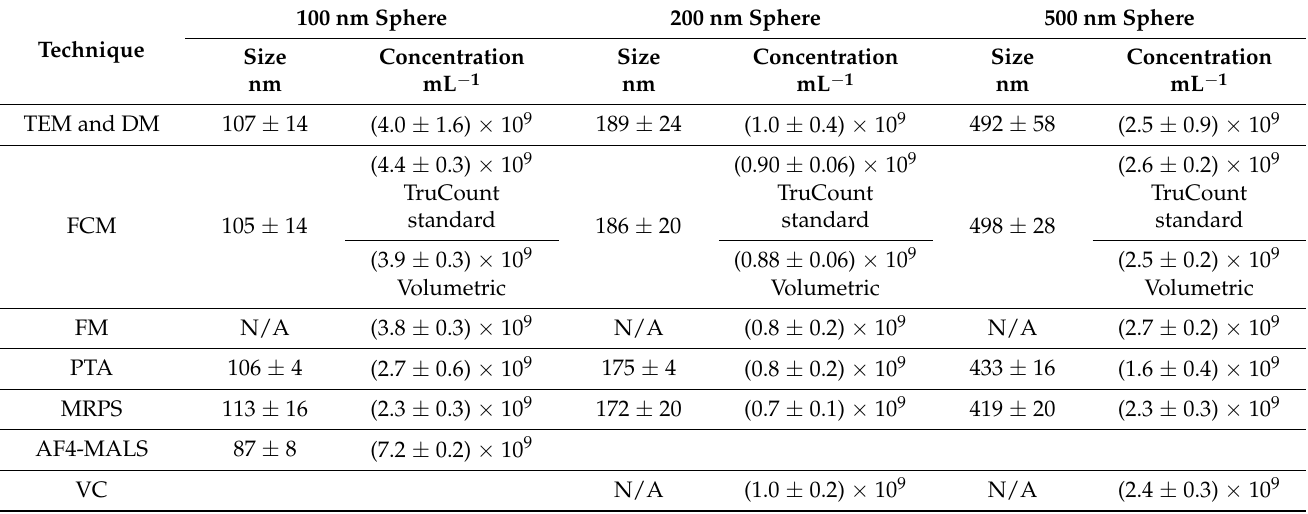
Table 1. Measured submicrometer sphere number concentrations and diameters for stock suspensions with expanded ( k = 2)